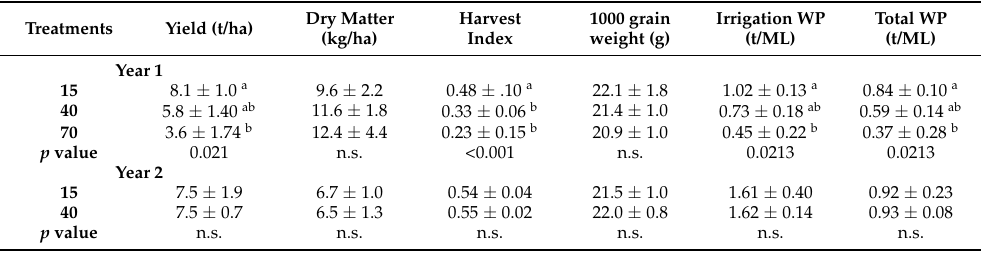
Table 5. Grain yield, yield components and water productivity for Year 1 and Year 2. Values ± standard deviation with different letters between rows indicating statistical significance at